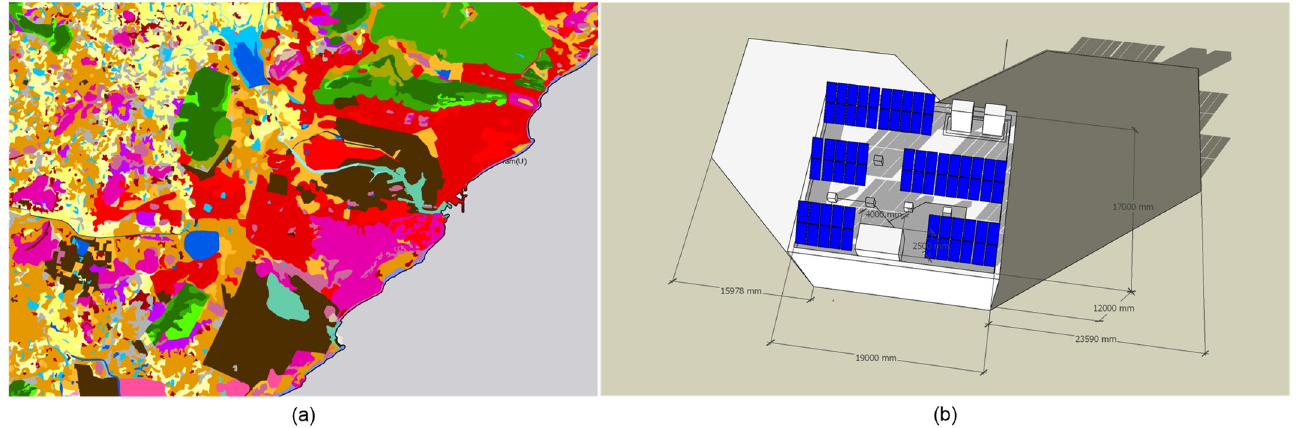
Figure 8. ( a ) Land cover of the proposed area. ( b ) Shading analysis of a proposed rooftop PV configuration over a building.